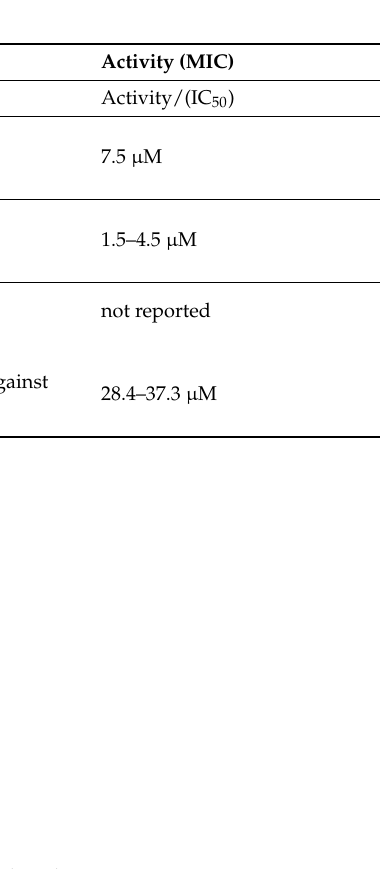
Figure 2. The proportions of marine fungi reviewed in this paper. Table 1. List of sesquiterpenoids isolated from marine fungi Aspergillus sp. with potential biologi- cal activity.